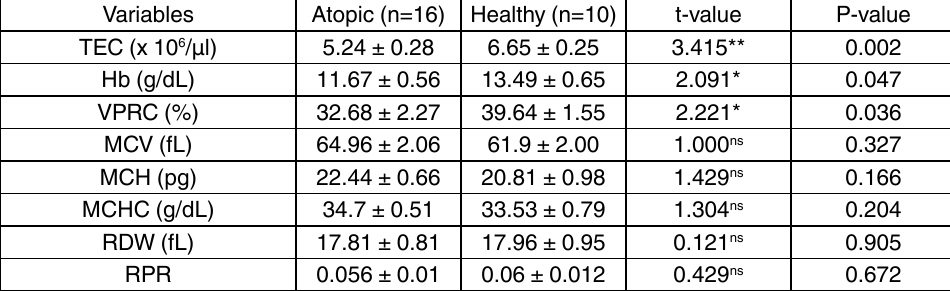
table 1. Haemogram in atopic animals and healthy controls Variables Atopic (n=16) Healthy (n=10)